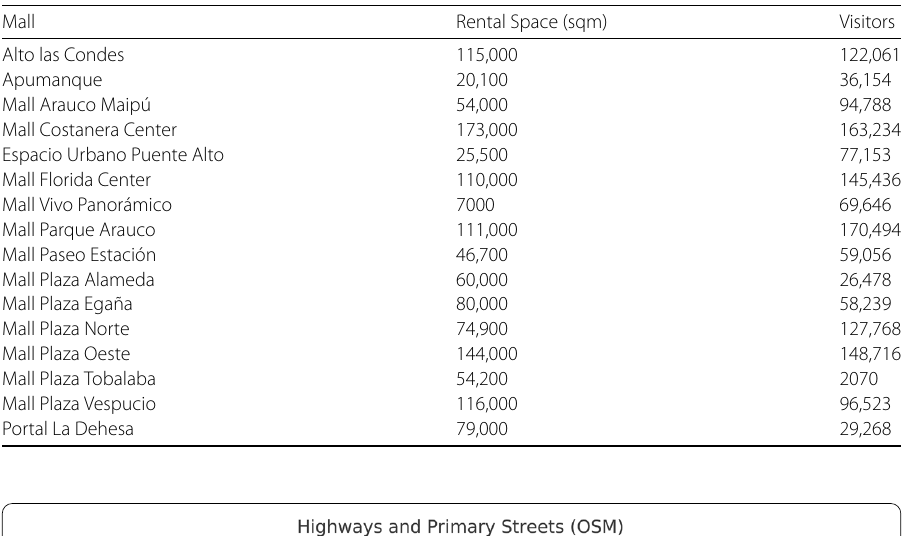
Table 1 Malls under study in Santiago, with their size in square meters (according to Chile’s Chamber of Commerce), and number of unique visitors in our dataset during August, 2016 Mall